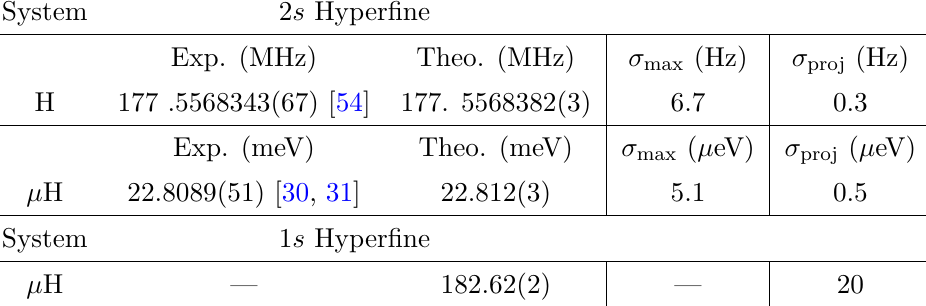
Table 2 . Table for the theoretical and experimental predictions of the hyperfine splitting in different muonic systems as well as in hydrogen. See the text for references to the theoretical computations and the origin of the projected